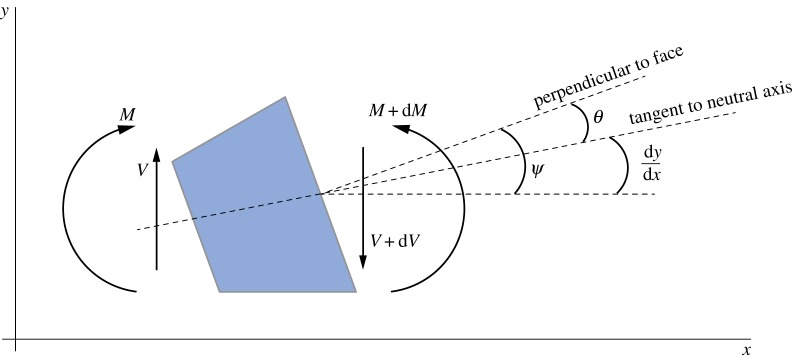
Free body diagram of an infinitesimal beam element. The sketch represents an infinitesimal element undergoing bending and shear deformations, assuming small deflections so that x≃s. The bending moment is denoted as M, the shear force as V , the vertical displacement as y. The bending angle ψ, the shear angle θ and the slope of the vertical displacement dxy are related to each other so that ψ=θ+dxy.